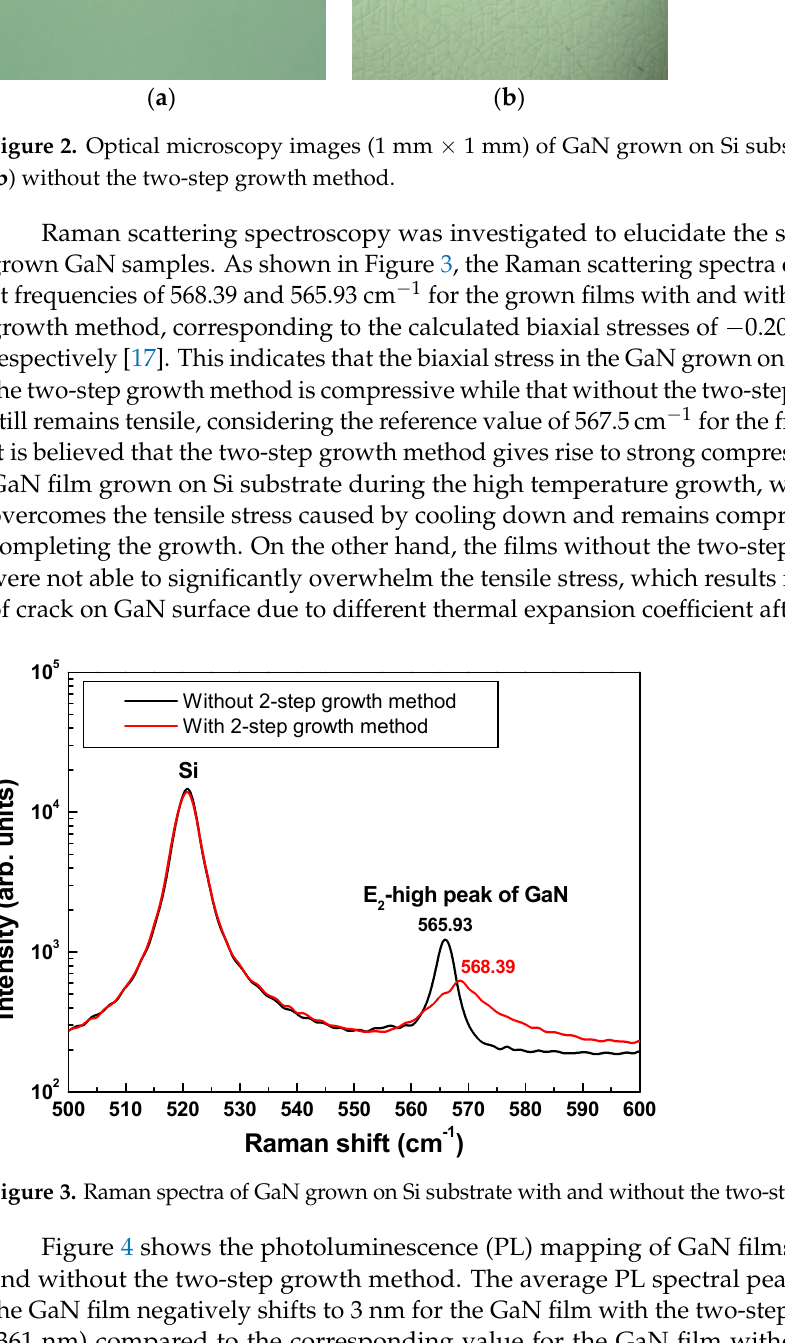
Figure 3. Raman spectra of GaN grown on Si substrate with and without the two-step growth method.